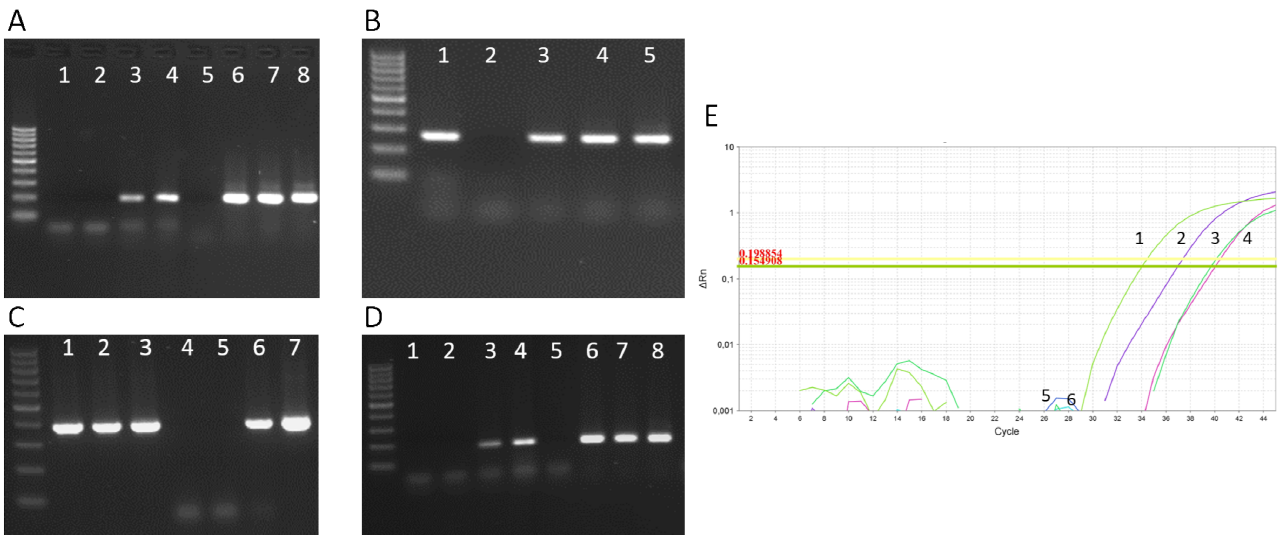
Figure 2. Gel electrophoresis blots ( A – D ) and real-time PCR amplification ( E ) of viral PCR amplicons of ( A ) three CVB3 positive samples (lanes 1 and 2 = ntc; lanes 3 and 4 = pc; lane 5 = negative patient sample; lanes 6–8 = CVB3 positive patient samples), ( B ) three EBV positive samples (lane 1 = pc; lane 2 = ntc; lanes 3–5 = EBV positive patient samples), ( C ) three HHV6 positive samples (lanes 1–3 = HHV6 positive patient samples; lane 4 negative patient sample; lane 5 = ntc; lanes 6 and 7 = pc), ( D ) three B19V positive patient samples (lanes 1 and 2 = ntc; lanes 3 and 4 = pc; lane 5 = negative patient sample; lanes 6–8 = B19V positive patient samples) and ( E ) one SARS-CoV-2 positive sample (1 = pc E-gene; 2 = pc Orf-gene; 3 = patient sample positive for SARS-CoV-2 E-gene; 4 = patient sample positive for SARS-CoV-2 Orf-gene; 5 = ntc E-gene; 6 = ntc Orf-gene). Abbreviations: ntc = no template control, pc = positive